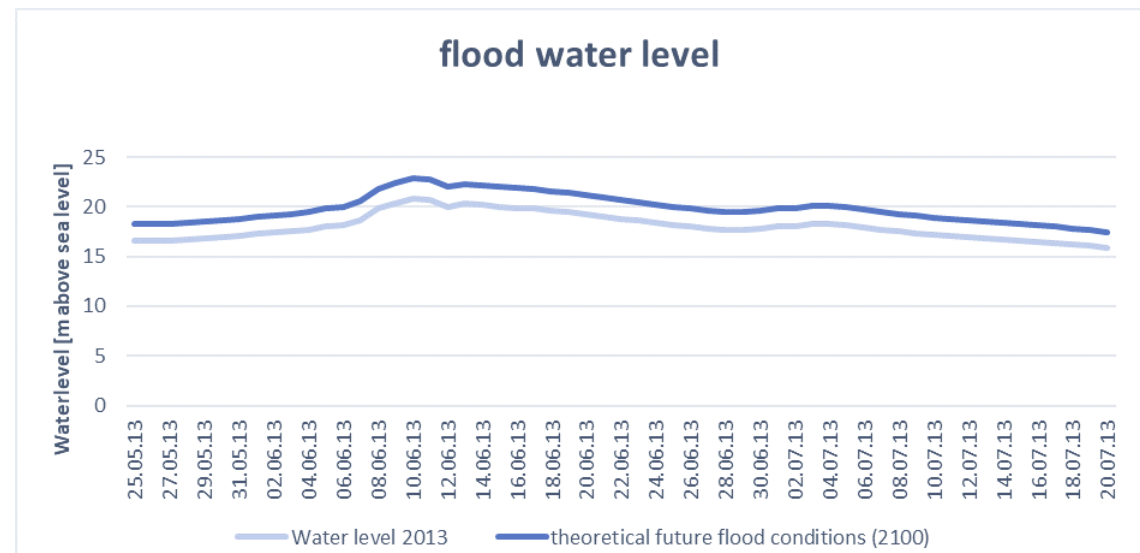
Figure 3. Water level of the summer flood 2013 at the Elbe river near Schnackenburg (IKSE n.d.) and theoretical future flood conditions for the year 2100 (IKSE n.d.; Nilson et al.